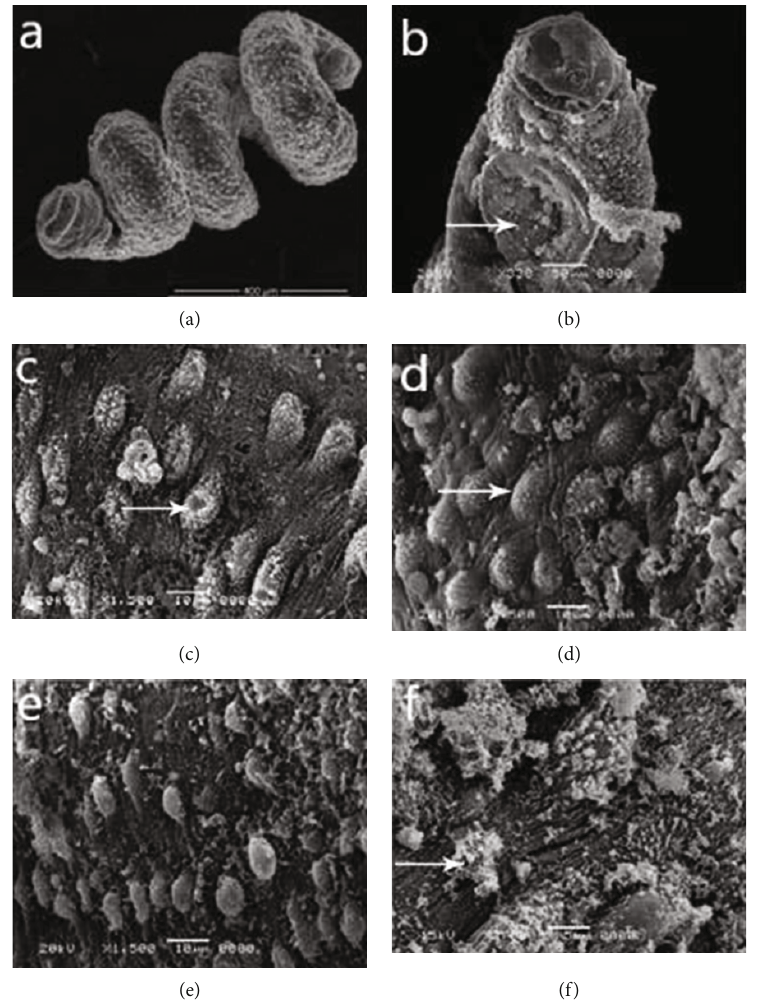
Figure 10: Scanning electron microscopy of S. mansoni (adult worms) after exposure to di ff erent concentration of Piper nigrum : (a) destroyed sucker; (b – d) male dorsal surface showing tegumental peeling with damage and peeling of tubercles and